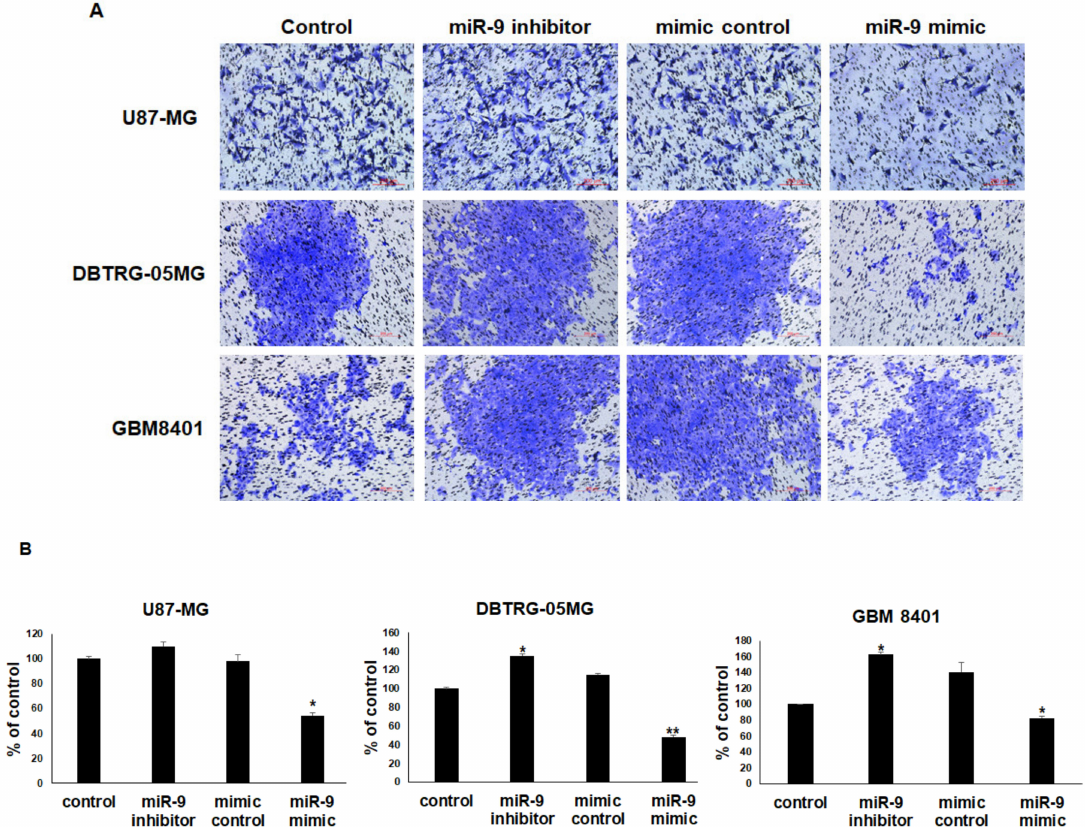
Figure 6. miR-9 significantly regulates the invasion ability of GBM cells. ( A ) Transwell invasion assays were used to evaluate the e ff ects of miR-9 on the invasion of GBM cells. Representative photographs of transwell invasion assays. ( B ) The bound crystal violet staining was released with 33% glacial acetic acid and quantified by absorbance measurements. Mean ± SD, n = 3. * p < 0.05; ** p <